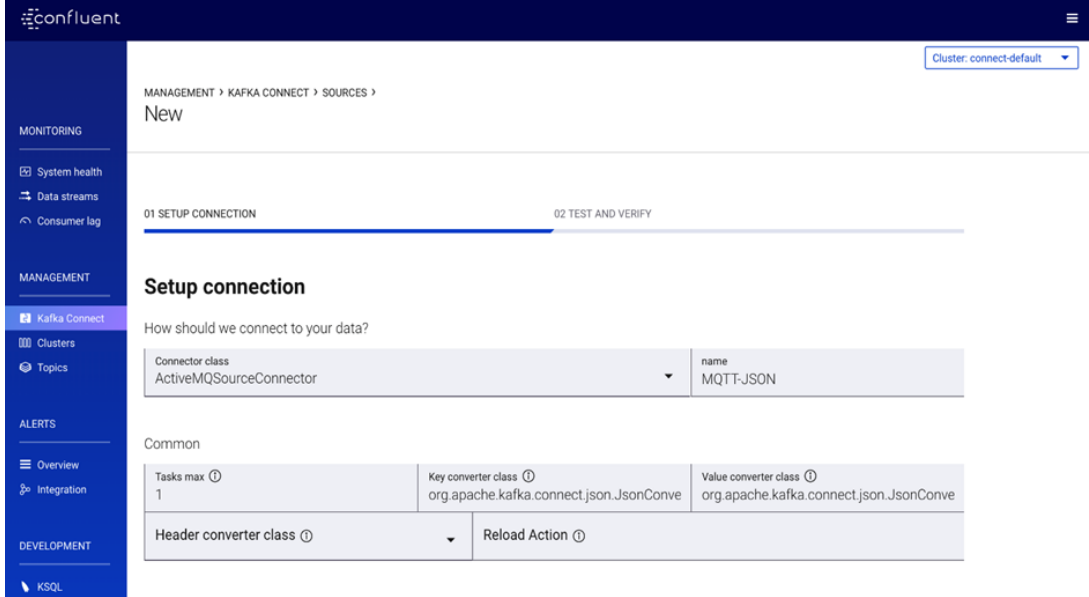
Figure 12. Configuration of Kafka Connect APIs in Confluent platform.